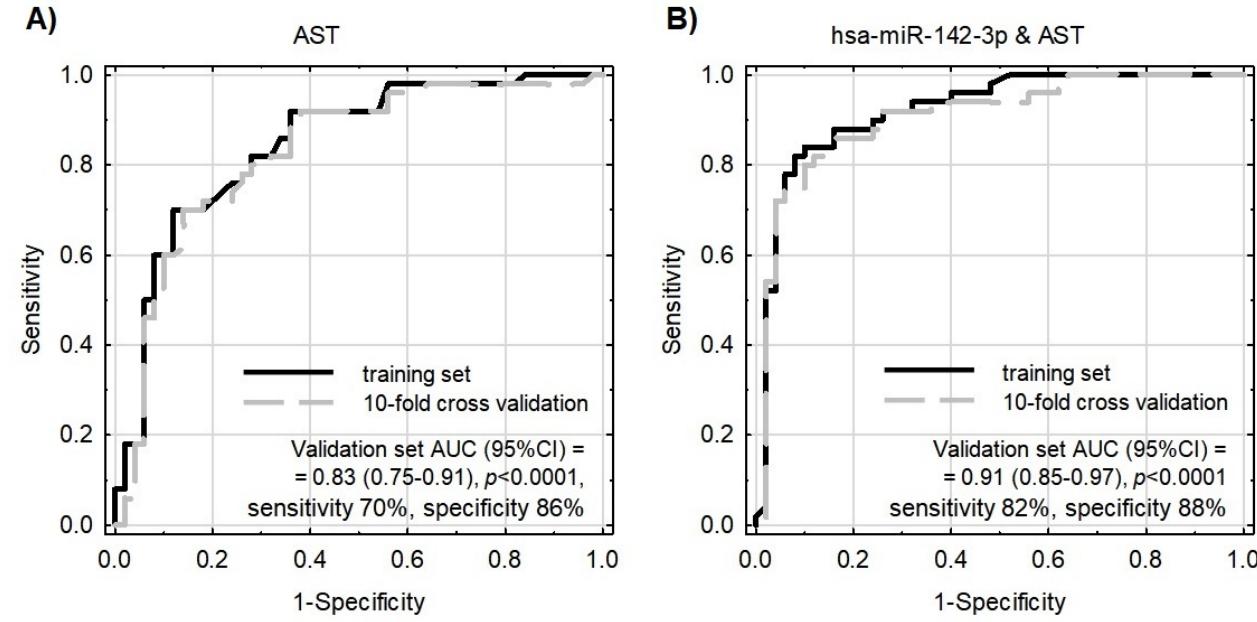
Figure 5. Receiver operating characteristic (ROC) curves for models differentiating ACS patients from healthy controls. Model internal validation was performed with a 10-fold cross-validation technique. ( A ) ROC for the model based on AST only. ( B ) ROC for the model based on miR-142-3p together with AST. Table 2. Characteristics of the binary logistic regression models differentiating ACS patients from healthy controls based on AST only and miR-142-3p together with AST.